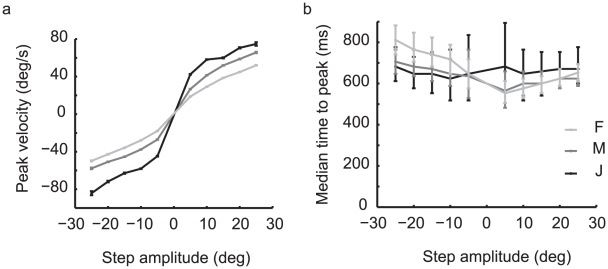
Peak response to a target step.a) Mean peak velocity by monkey and step size. Error bars represent the standard error of the mean. b) Median time to the peak response by monkey and step size. Error bars span the first and third quartiles of the data.